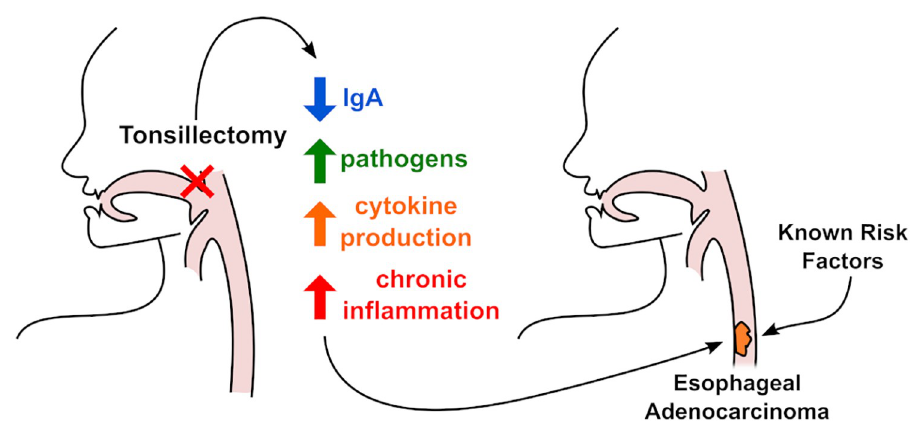
Fig 2. Illustration depicting possible association between tonsillectomy, inflammatory dysregulation, known EAC risk factors and development of EAC. Inflammatory dysregulation is proposed as an area for future investigation rather than as an established mechanism of